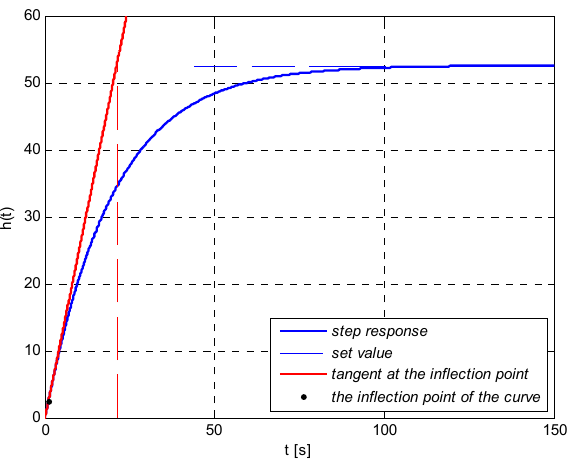
Figure 15. The approximation of the parameters of the fluctuating response of an object described with the following dependency (25). Table 3. The determined parameters of the fluctuating response of the object (25) and calculated PID controller settings.